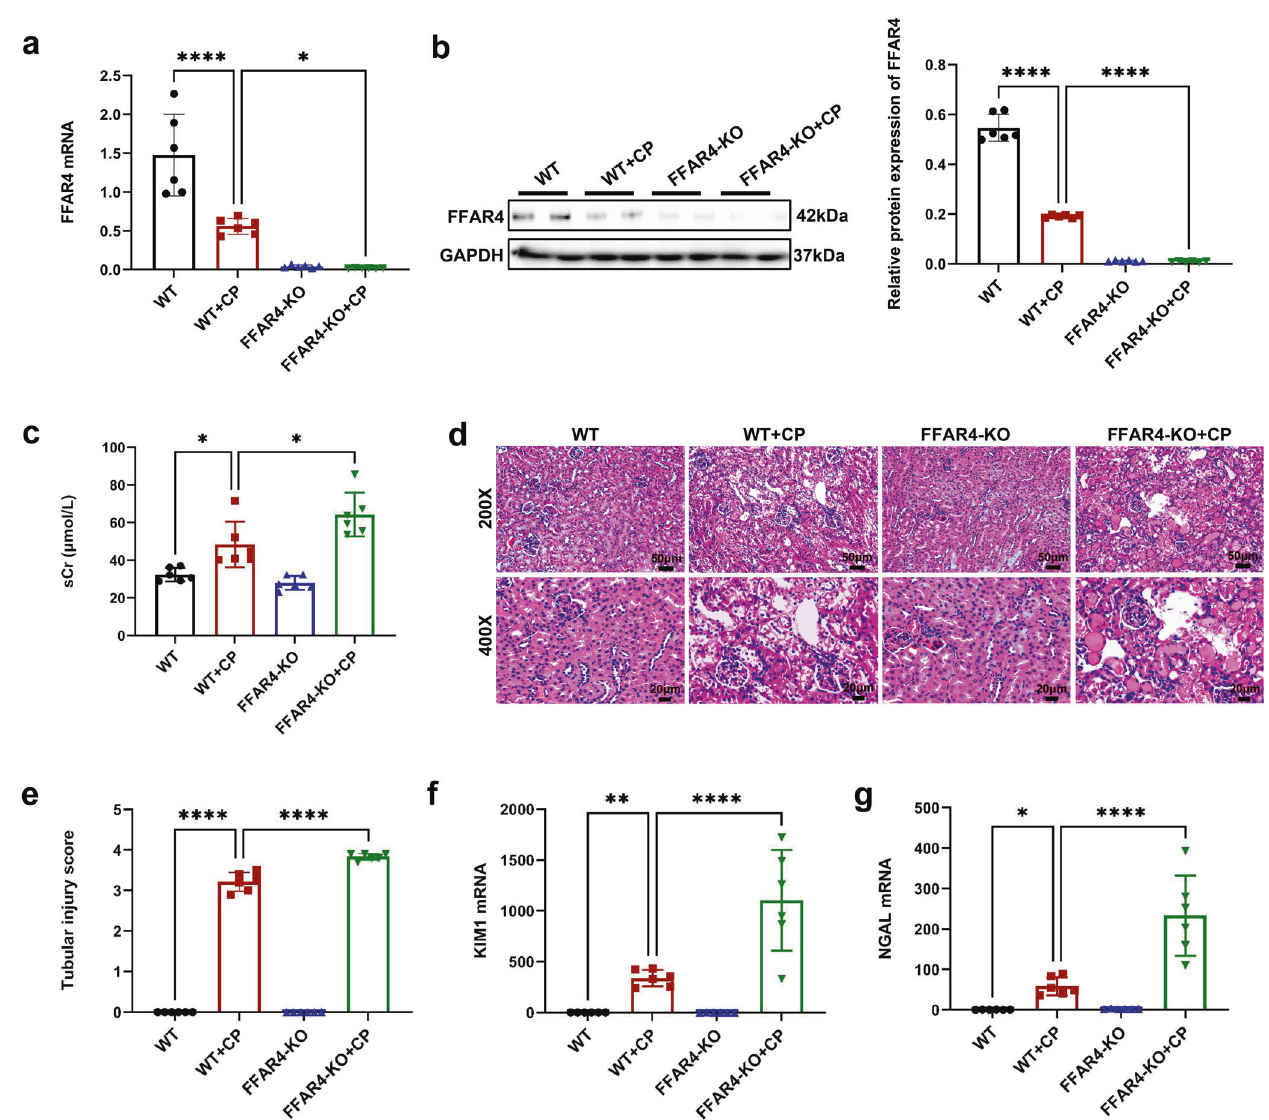
Fig. 2 FFAR4 de fi ciency aggravated cisplatin-induced AKI in mice. a Relative mRNA expression of FFAR4 in kidney tissues ( n = 6). b Protein expression of FFAR4 in kidney tissues detected by western blotting and quanti fi ed by densitometry ( n = 6). c The sCr level in different groups of mice ( n = 6). d Representative images of H&E staining (200×, scale bar = 50 μ m; 400×, scale bar = 20 μ m). e Tubular injury scores of kidney tissues ( n = 6). f Relative mRNA expression of KIM1 in kidney tissues ( n = 6). g Relative mRNA expression of NGAL in kidney tissues ( n = 6). Data are presented as mean ± SD. CP, cisplatin. **** P < 0.0001, ** P < 0.01, * P <